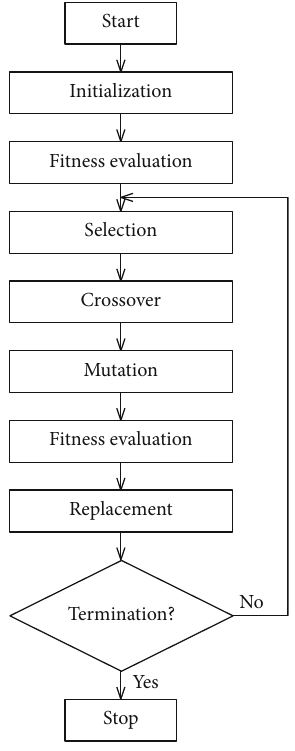
Figure 5: Block diagram of the basic genetic algorithm.